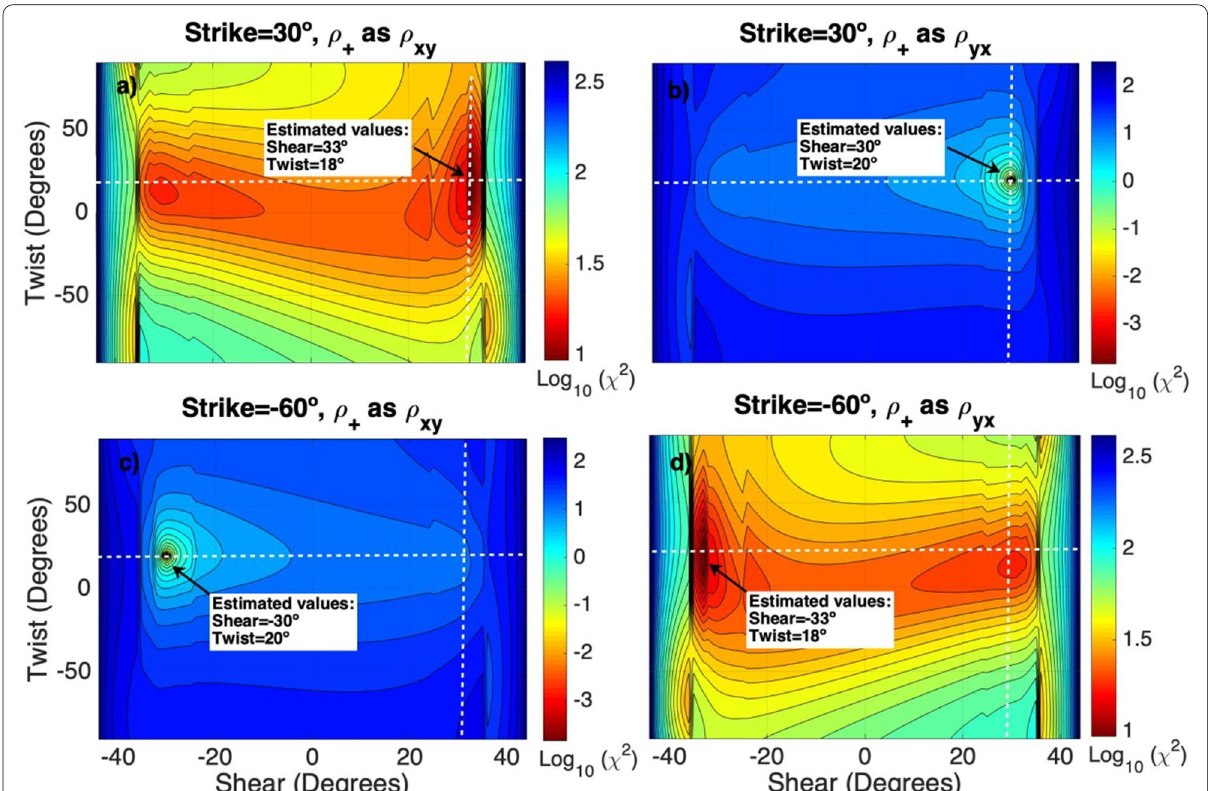
as ρ xy with a large misfit. b Strike of 30º and ρ as ρ yx with a small + + 60º strike (see text for details) −